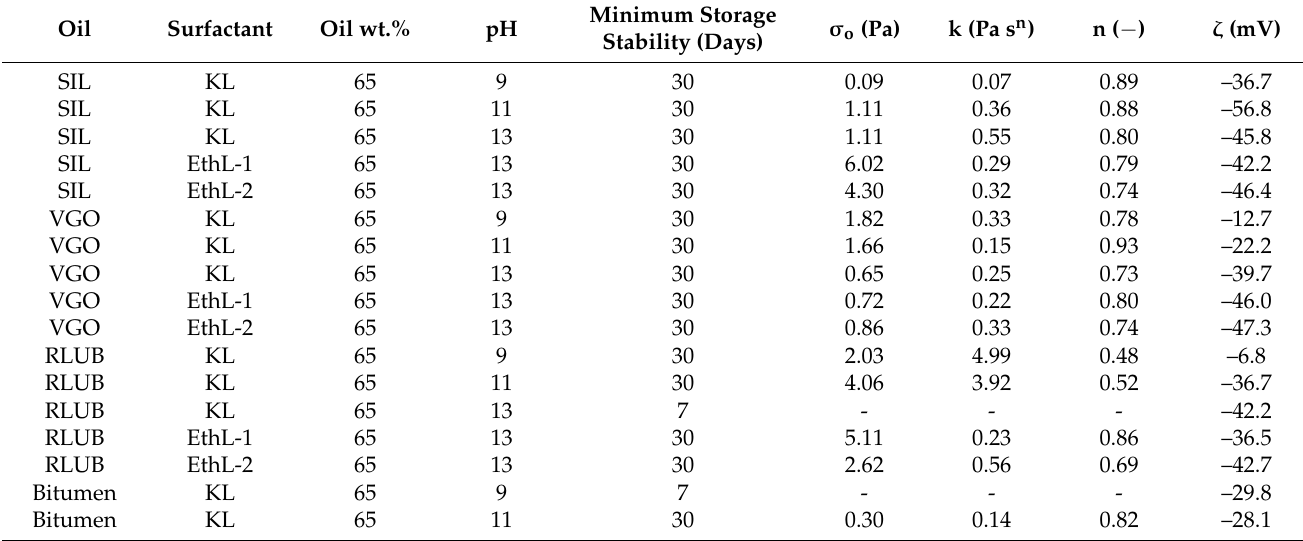
Table 2. Effect of formulation on emulsion storage stability, Z potential values ( ζ ) and Herschel-Bulkley model parameters. Measurements were performed after 7 days